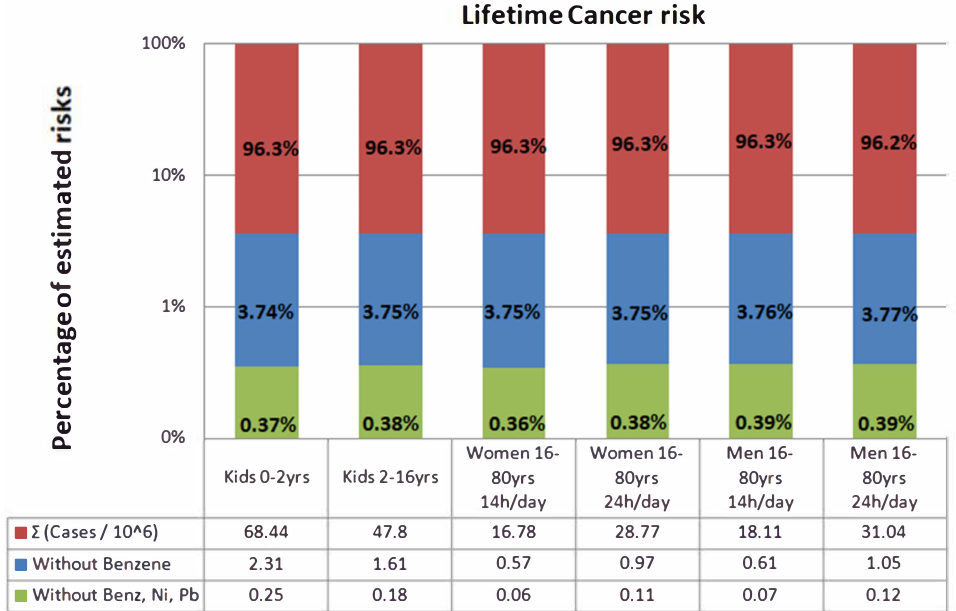
Figure 3. Percentage of cancer risk assessment (C.I